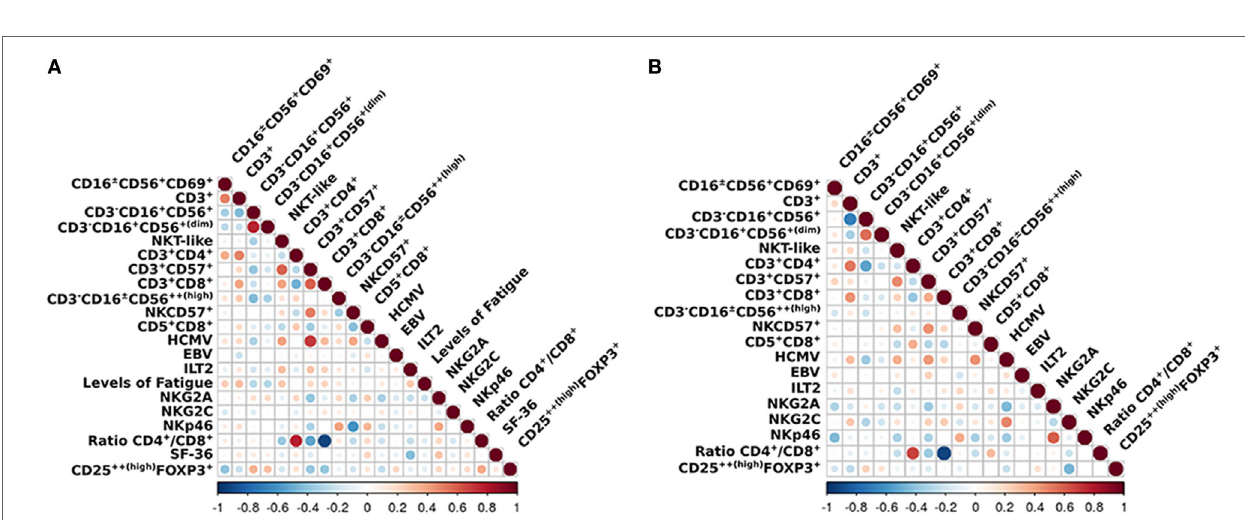
FigUre 4 | Fresh blood was stained with the antibodies described in Section “Materials and Methods.” Representative plots of NKp46, NKG2C, and CD56 ++ (high) of a myalgic encephalomyelitis/chronic fatigue syndrome patient (tube 017) and a healthy control (tube